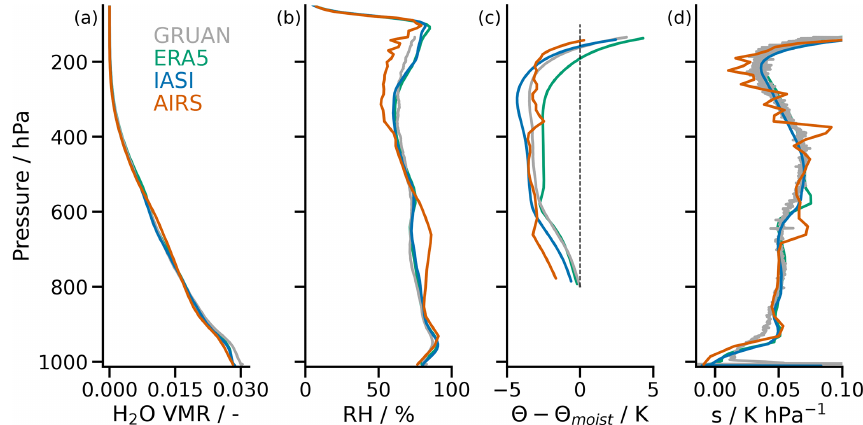
Figure 2. Mean profiles of (a) H 2 O volume mixing ratio (VMR), (b) relative humidity (RH), (c) deviation of potential temperature ( (cid:50) ) from moist adiabat ( (cid:50) moist ) based on mean (cid:50) at 700hPa of GRUAN data and (d) the static stability s in the vicinity of Manus Island based on the four investigated datasets. Only collocated data with ERA5 are used. For the ERA5 profiles, collocated data with IASI are